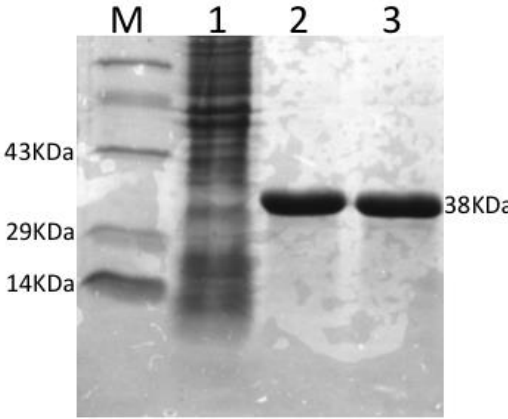
Figure 2. Expression of rOmpA protein. Lane M: Molecular protein marker; Lanes 1: Un-induced recombinant E.coli M-15 cell; Lane 2 and 3: Purified rOmpA.